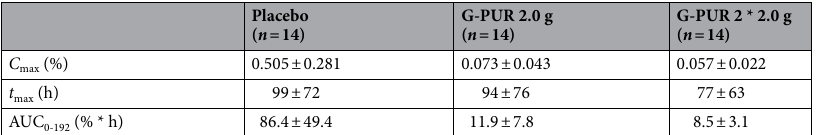
Table 2. 204 Pb pharmacokinetic parameters after single oral intake of 2.5 µg 204 Pb in water by treatment groups. 204 Pb enrichment is expressed as molar fraction (%) of total blood lead, normalized for hematocrit and body mass index. Data are means ± SD .